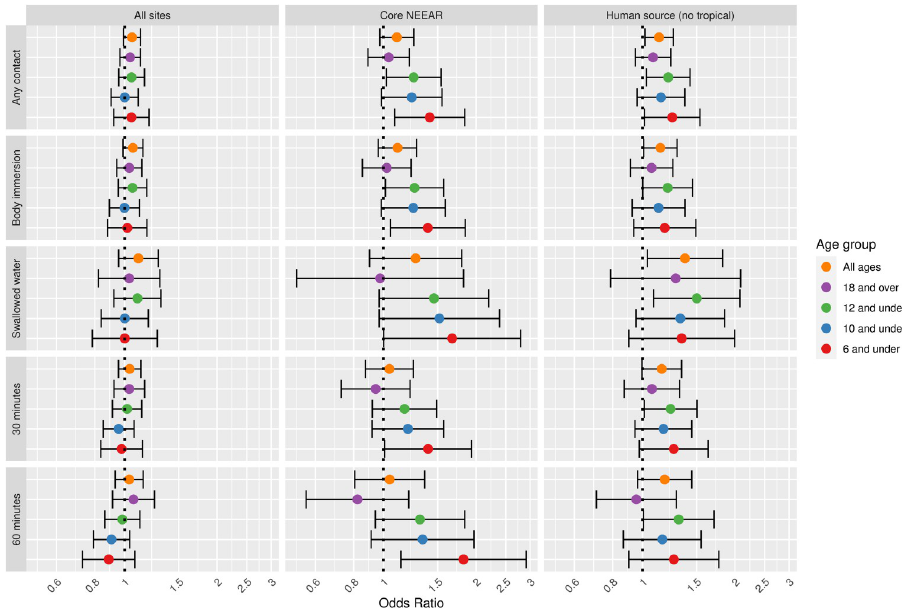
Fig 2. Odds ratios for NEEAR-GI illness among swimmers associated with a 1-log10 increase in Enterococcus CFU.